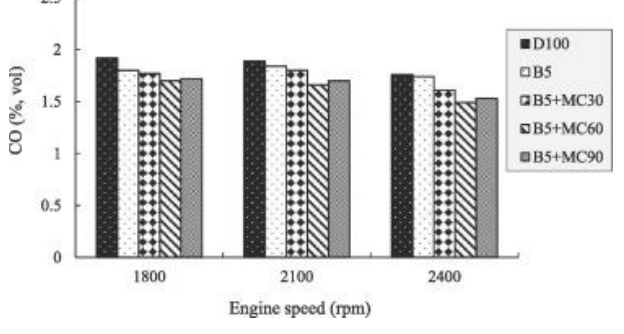
Fig. 6. Effect of the additive on CO emission [14]